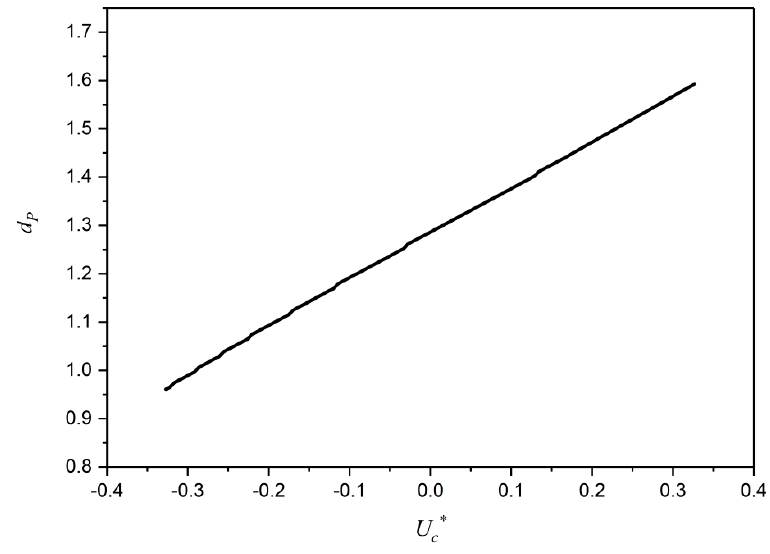
Figure 6. Peak value of the dimensionless mud thickness versus the current velocity.